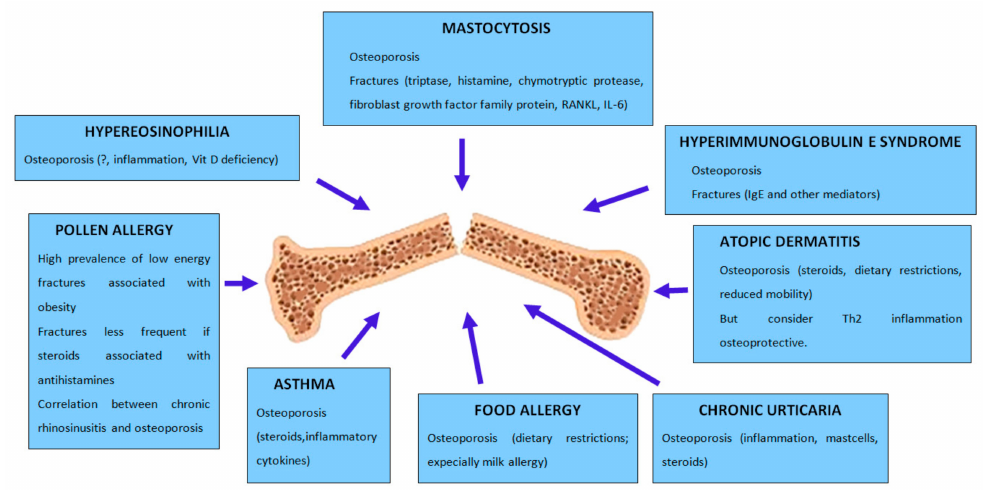
Figure 1. The figure summarizes the relationship between allergic diseases and skeletal